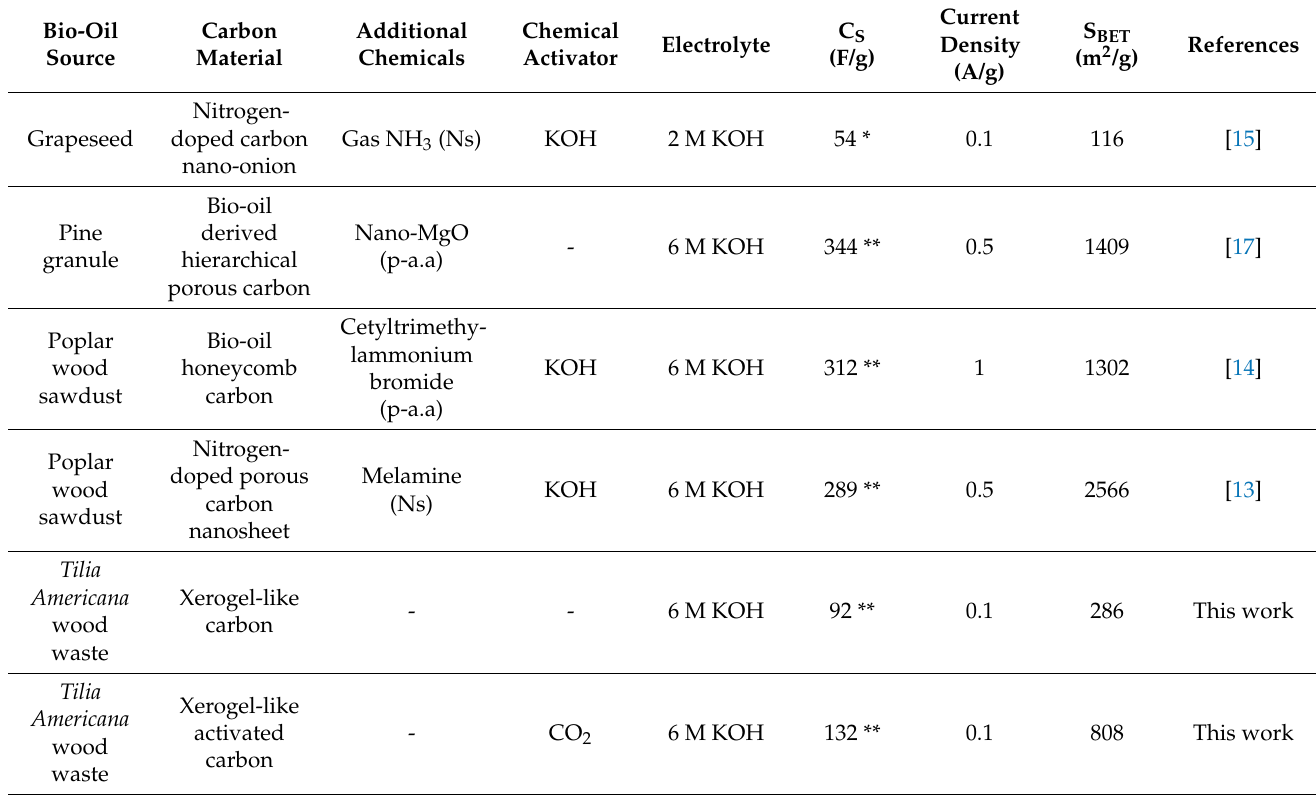
Table 4. Synthesis steps, electrochemical performance and S BET of carbons prepared with bio-oil from different bio-sources. Bio-Oil